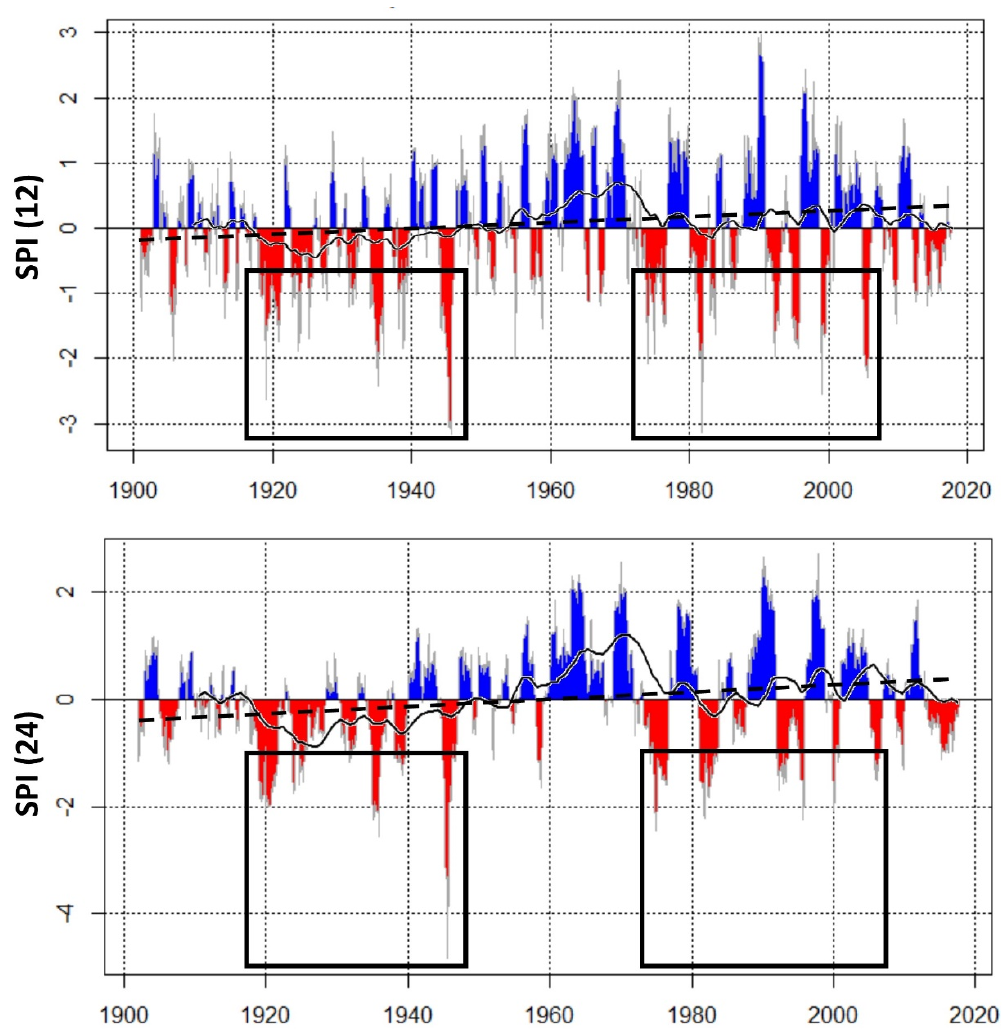
Figure 3. Standardized Precipitation Index for 12-month (SPI 12) and 24-month (SPI 24) time scales in the Lower Guadiana River Basin. Cycles of about 25–30 years with predominance of moderate and severe drought events occurred (these global drier cycles are marked in this figure by rectangles). Dashed lines indicate linear trend of fit and solid lines indicate the 10-year moving average of the SPI(12) and SPI(24) series.